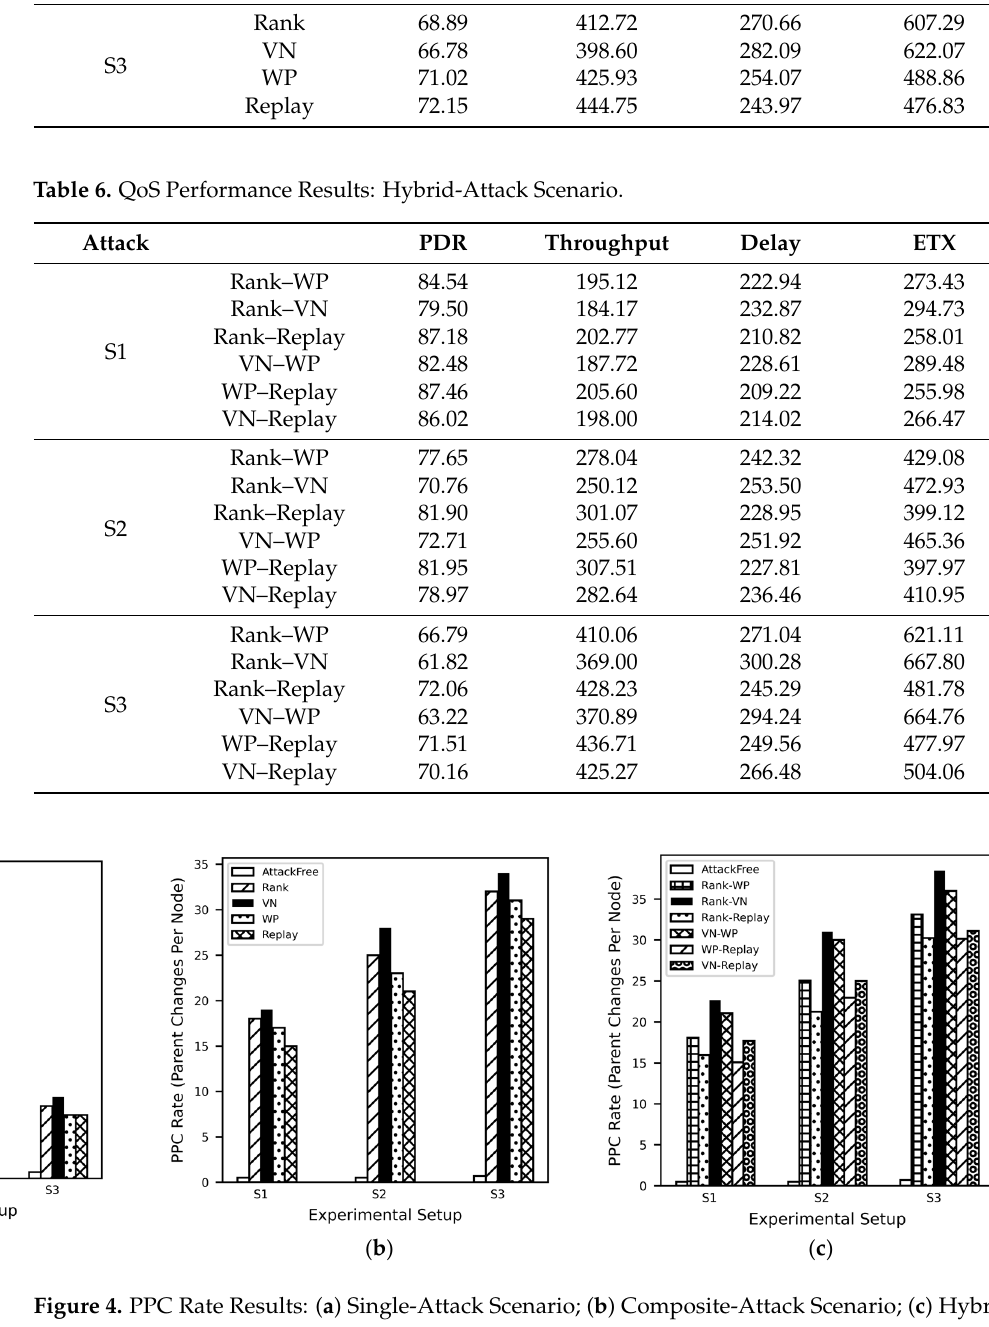
( c ) Figure 5. Average Beacon Interval Results: ( a ) Single-Attack Scenario; ( b ) Composite-Attack Sce- nario; ( c ) Hybrid-Attack Scenario.